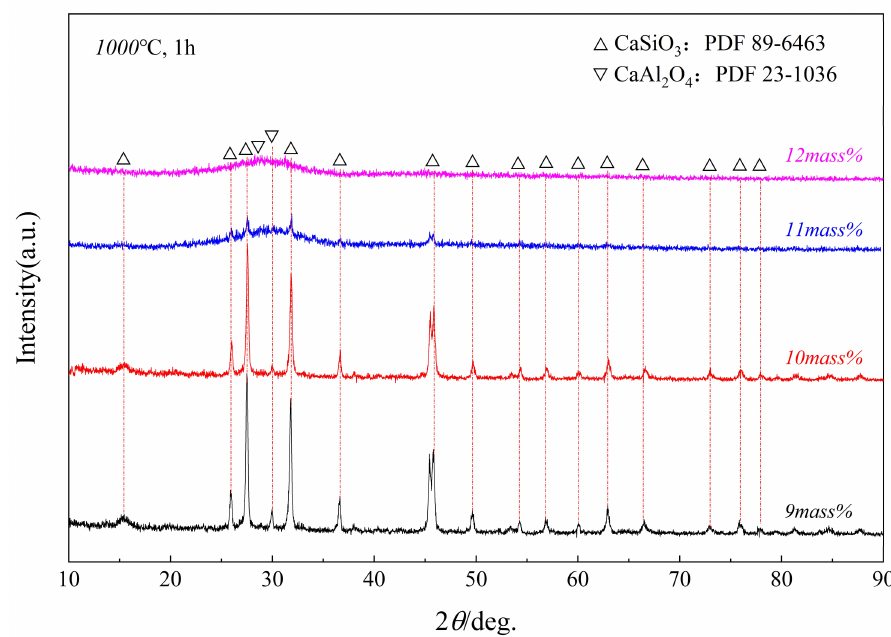
Figure 10. XRD patterns of samples of glass phases with different Al 2 O 3 contents after being held at a constant temperature of 1000 ◦ C for 1